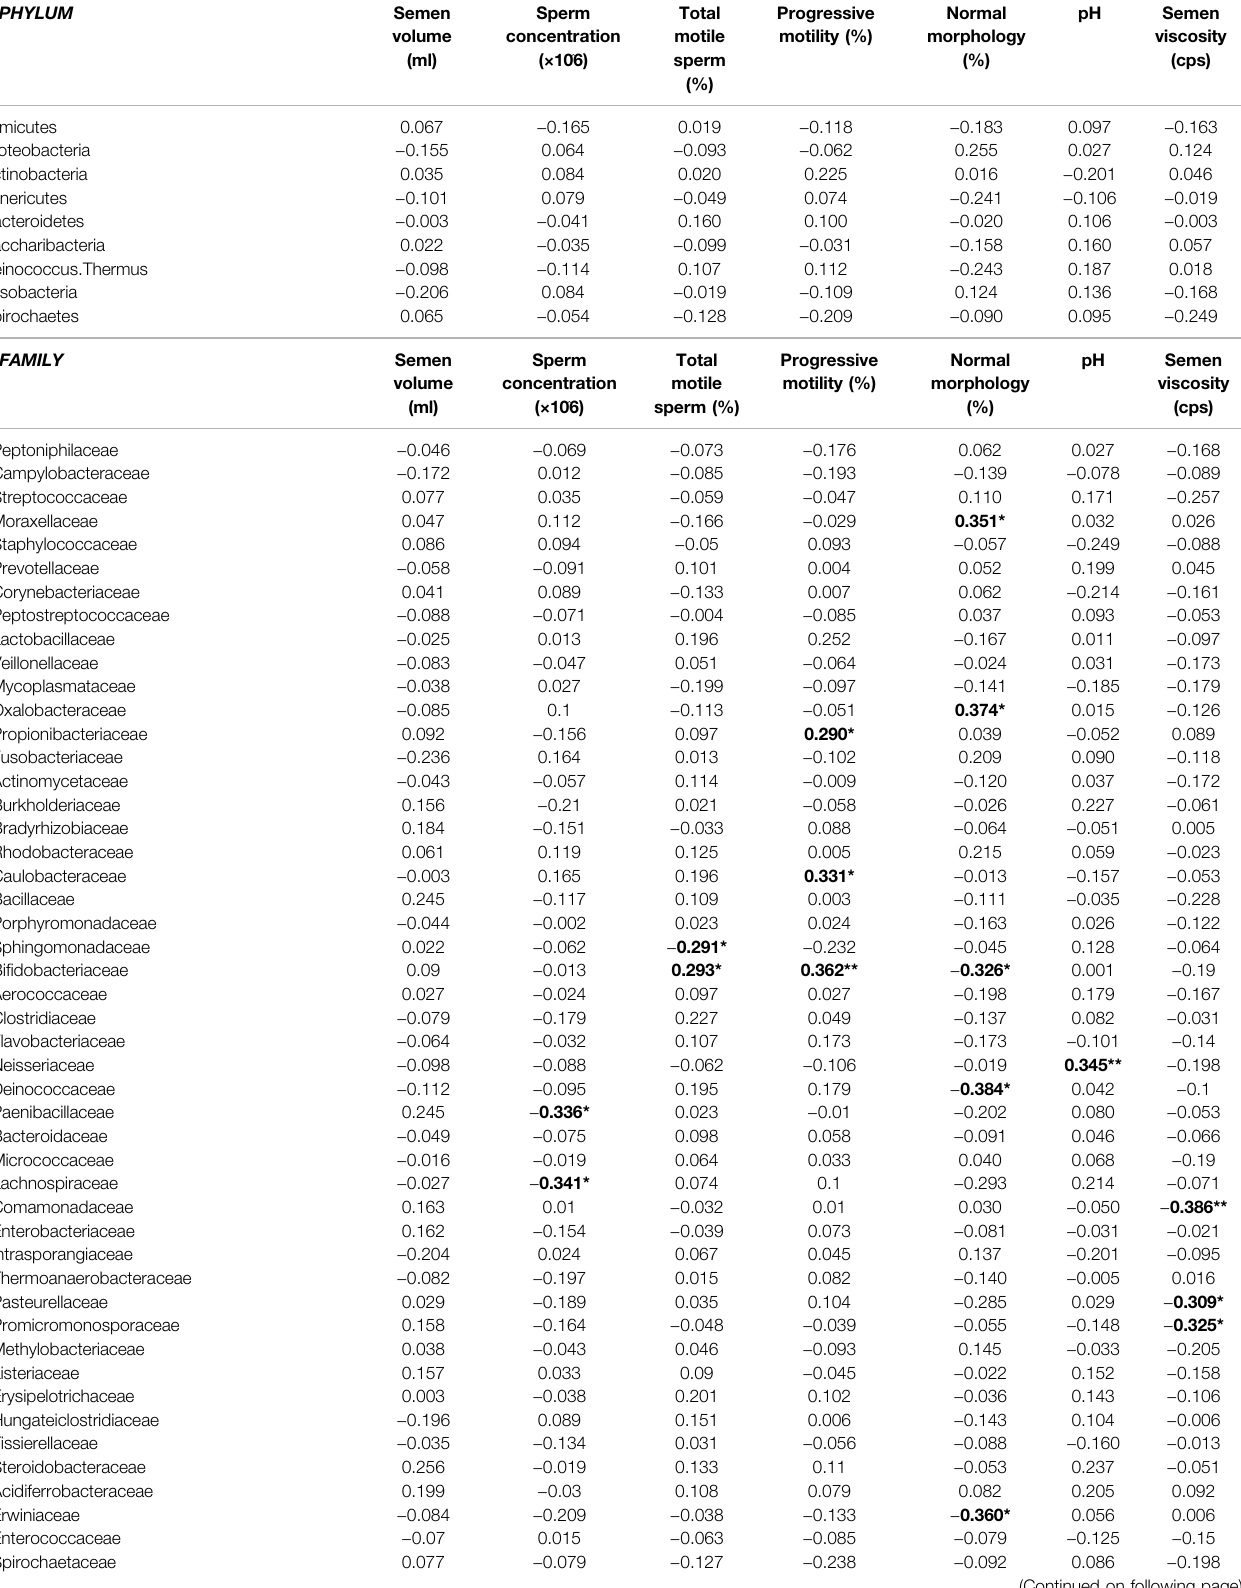
TABLE 4 | Correlation coef fi cients for the abundance of identi fi ed (A) phylum, (B) family or (C) genera and basic sperm quality